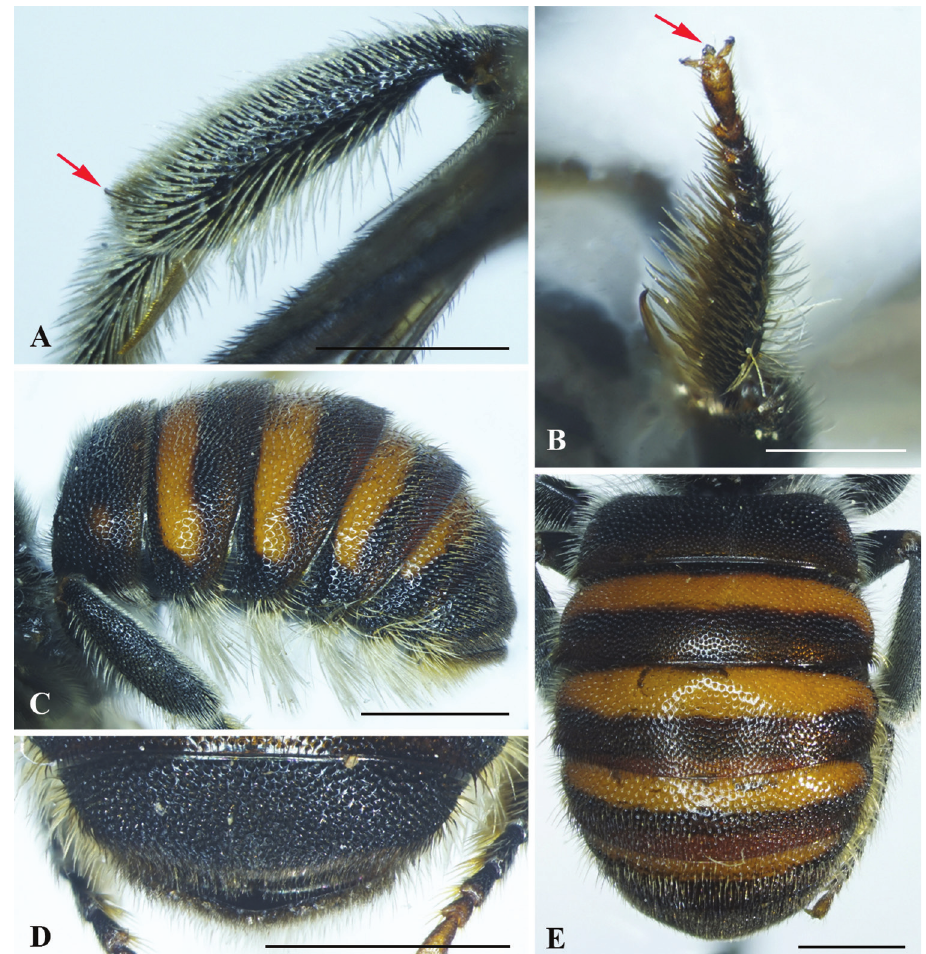
Figure 2. A–E Bathanthidium ( Bathanthidium s. str.) paco Tran & Nguyen, sp. nov., holotype, female A middle tibia in dorso-lateral view, showing the tibial spine B distitarsus of hind leg in frontal view, showing the arolium C metasoma in lateral view D T6 in dorsal view E mesoscutum and scutellum in dorsal view. Scale bars: 1 mm ( C, D, E ); 0.5 mm ( A, B